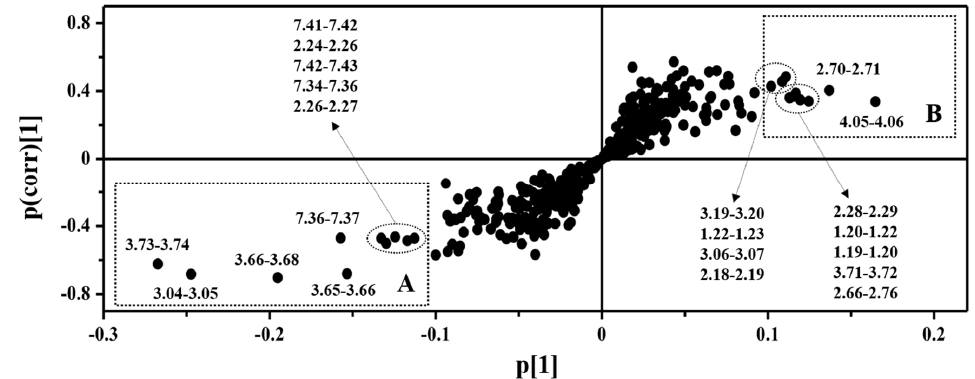
Figure 3. S-Plot corresponding to the OPLS-DA model used to characterize the most significant variables associated with group C (dotted rectangle A) and CRC (dotted rectangle B) subjects. Cutoff values for the covariance of | p | ≥ 0.1 and for the correlation | p (corr)| ≥ 0.2 were used. Values of discriminant ppm regions are shown.